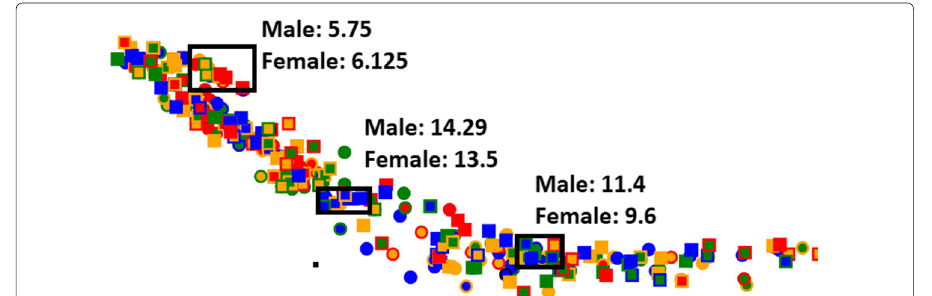
Fig. 22 Isomap for "Mathematics" class, period 2, considering both genders